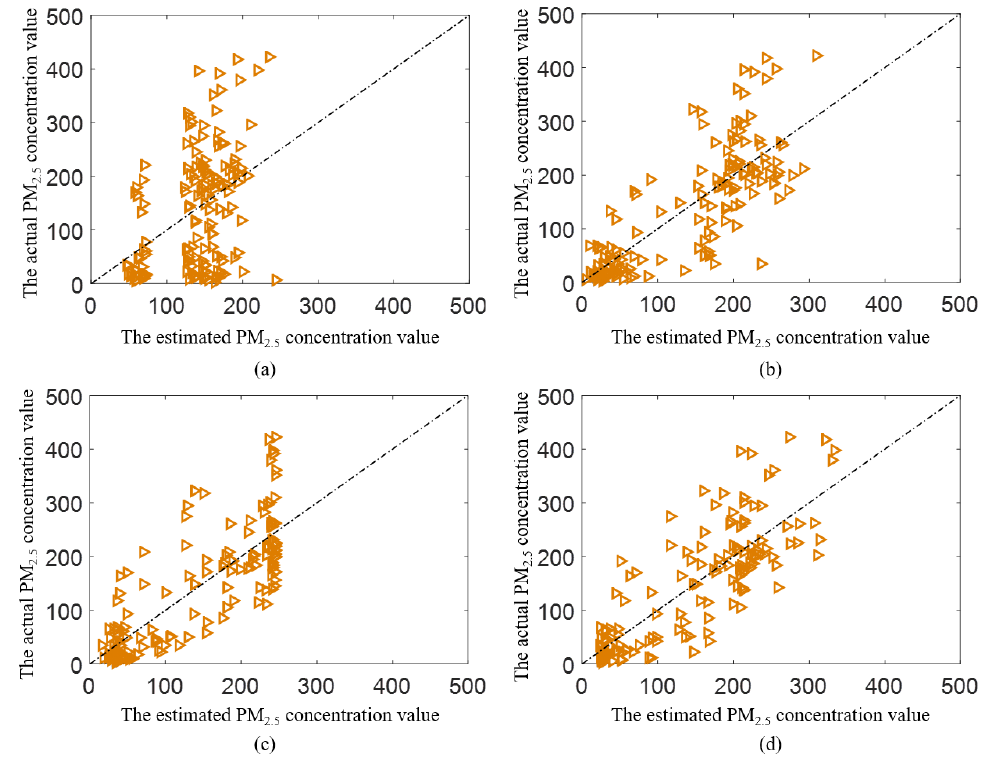
Figure 6. Scatter plot of the PM 2.5 concentration estimation results. The black dashed line represents the benchmark perfect estimation. ( a ) Estimated by BIQME [36]. ( b ) Measured by Sun et al.’s method [33]. ( c ) Estimated by PPPC [20]. ( d ) Measured by our proposed